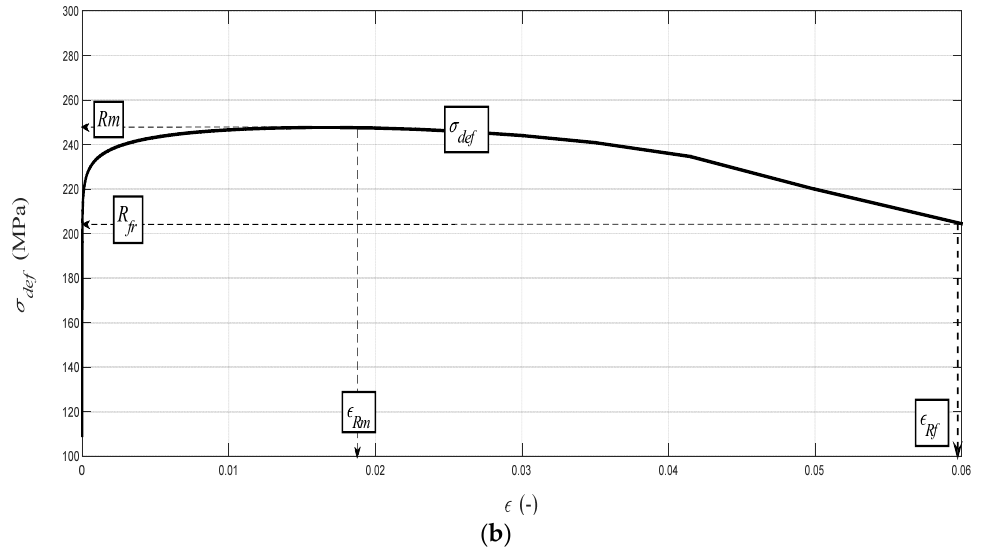
Figure 6. ( a ) Deformational diagram σ def = f ( A ) for the Al-alloy AW6083T6 from tensile test; ( b ) Analytical deformational diagram for AW6083T6, for the dependence σ def = f ( A ); comparison diagram.